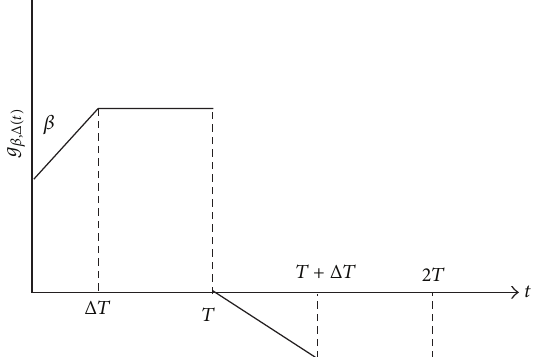
Figure 1: Samples in MFROH.